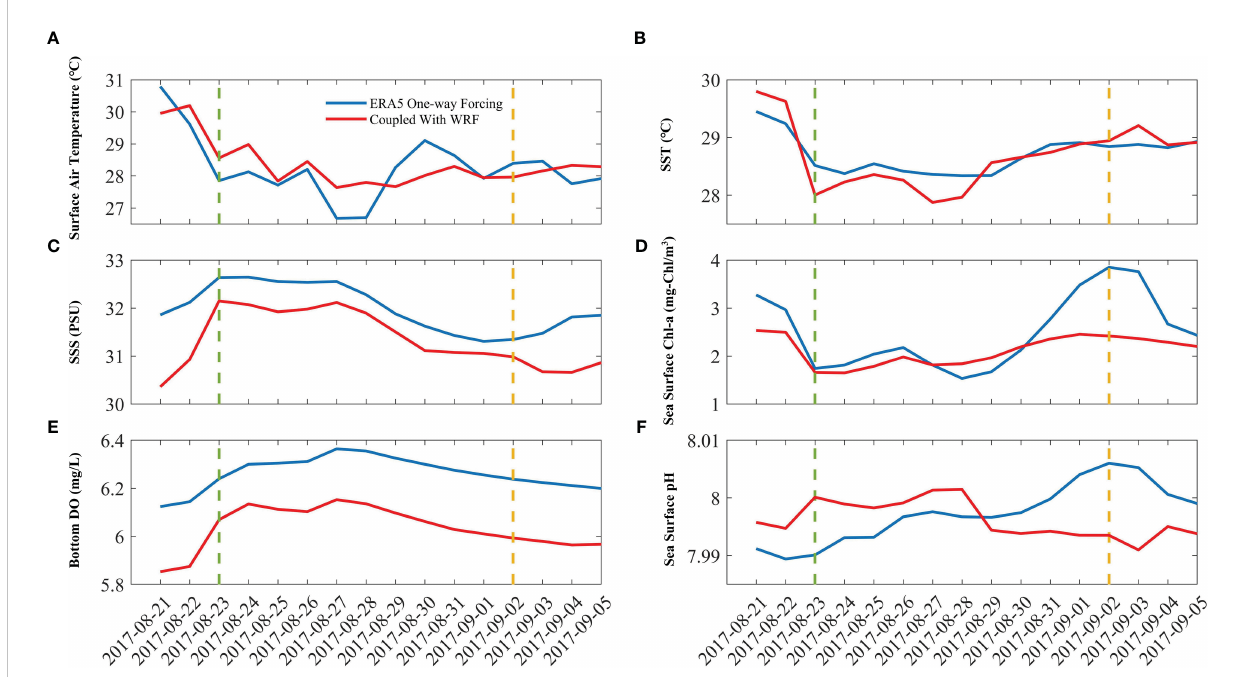
lines depict timings for Hato (2017) passing by the PRE. The simulated passage of Hurricane Hato (2017) is shown in Figure